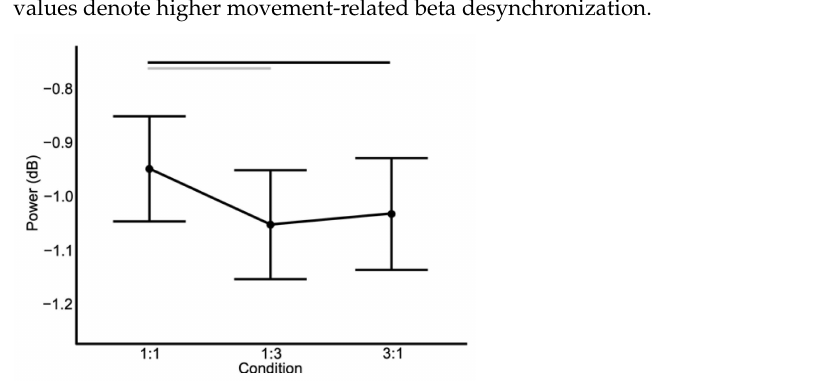
Figure A3. Interaction profile plot for effect of complexity on beta power during movement planning, irrespective of laterality. This plot was made for the sake of comparability with previous research. Black lines denote significant contrasts ( p < 0.050), gray lines denote marginally significant contrasts ( p =